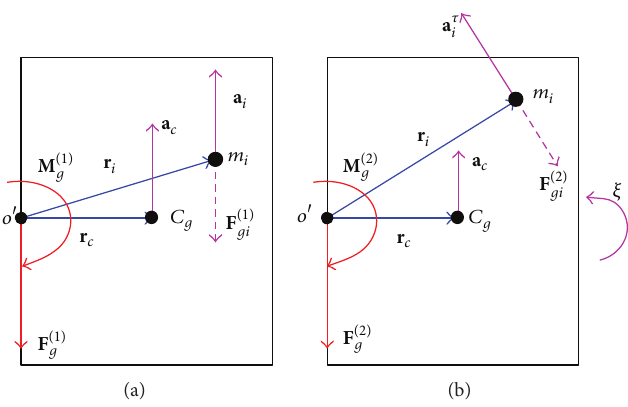
Figure 2: Simplification of the tip-mass to point 𝑜 󸀠 under (a) translational motion and (b) rotational motion.